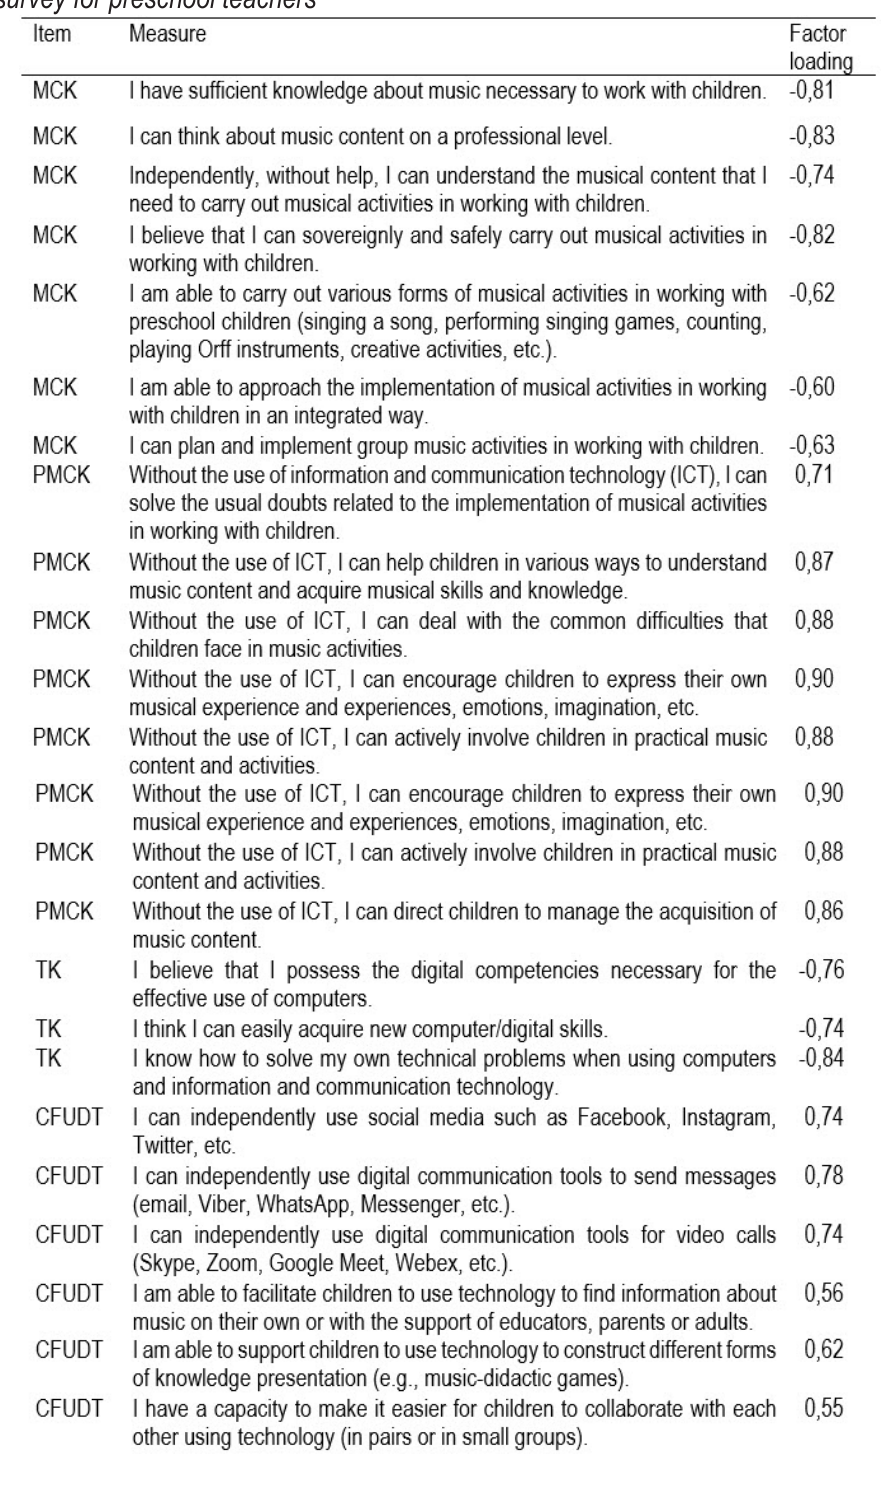
Rotated Factor Scores from Pattern Matrix (Oblimin Rotation) for the scales of the adapted TPACK- TCCMA survey for preschool